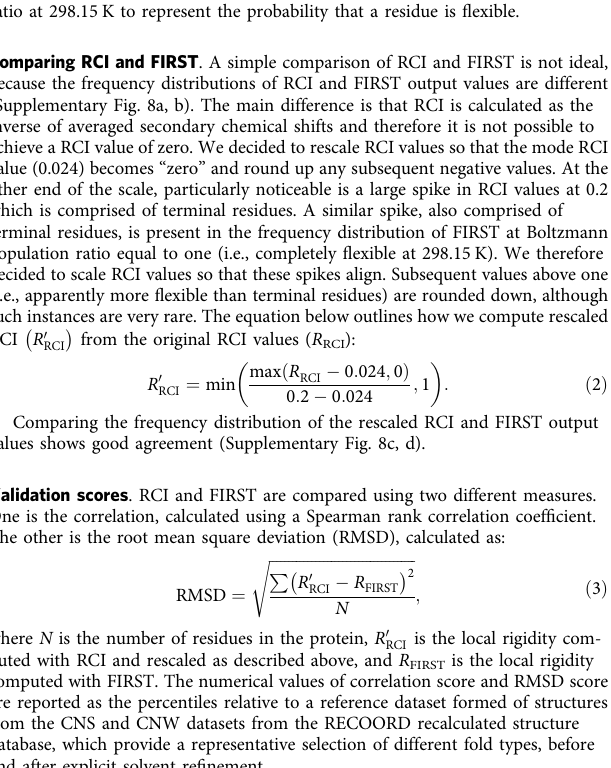
Supplementary Table 3. X-ray structures required some processing. If the structure contained multiple conformations (typical in high resolution X-ray structures), then we only considered the fi rst of these as they appeared in the PDB fi le. Missing atoms and small breaks in the protein structure were identi fi ed using an in-house program and fi xed using MODELLER 58 . MODELLER was also used to replace non-standard residues related to conditions required for crystallization (e.g., selenomethionine was replaced with methionine). Structures were protonated using REDUCE with the option to optimize adjustable groups 59